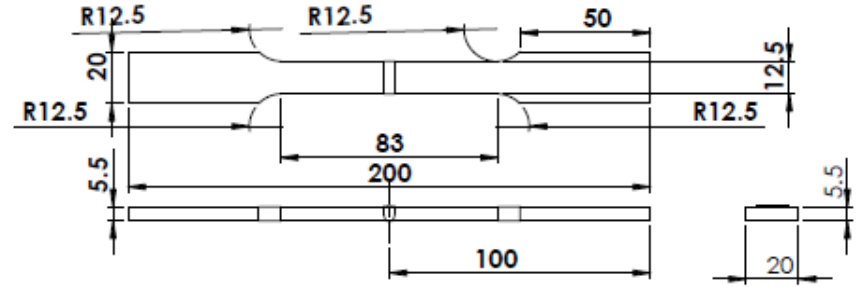
Figure 3. Test specimen for the tensile test (units in mm).